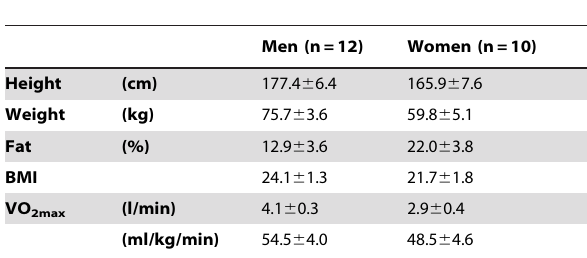
Table 1. Subject